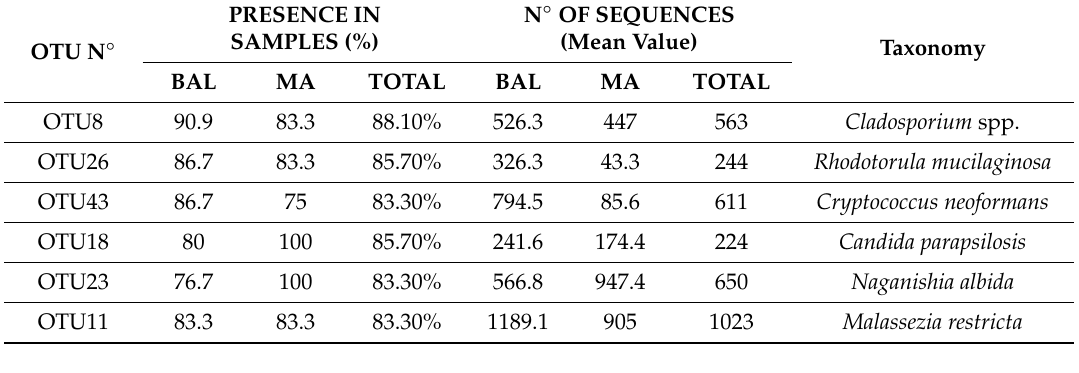
Figure 4. Global distribution of putative fungal species detected in BAL, ENV, and BS samples. The intensity of the color corresponds with the number of sequences in a logarithmic scale. The left column shows the identification number of each specific OTU and their correspondent species are in the right column. Table 5. OTUs that were the most prevalent in both kinds of samples. Percentage of samples in which they were detected and abundance in the number of sequences.